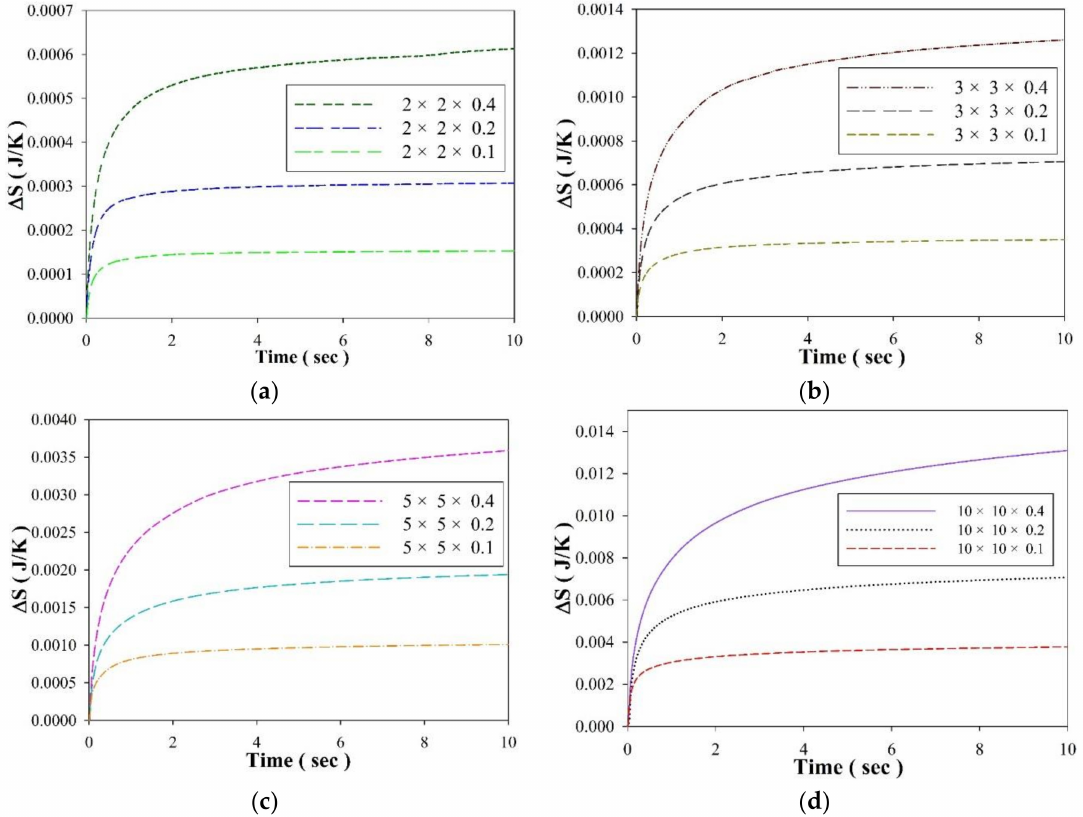
Figure 7. Entropy variations ( ∆ S) of the PZT cells with various thicknesses and geometries of: ( a ) 2 mm × 2 mm, ( b ) 3 mm × 3 mm, ( c ) 5 mm × 5 mm and ( d ) 10 mm × 10 mm in the thermal bath